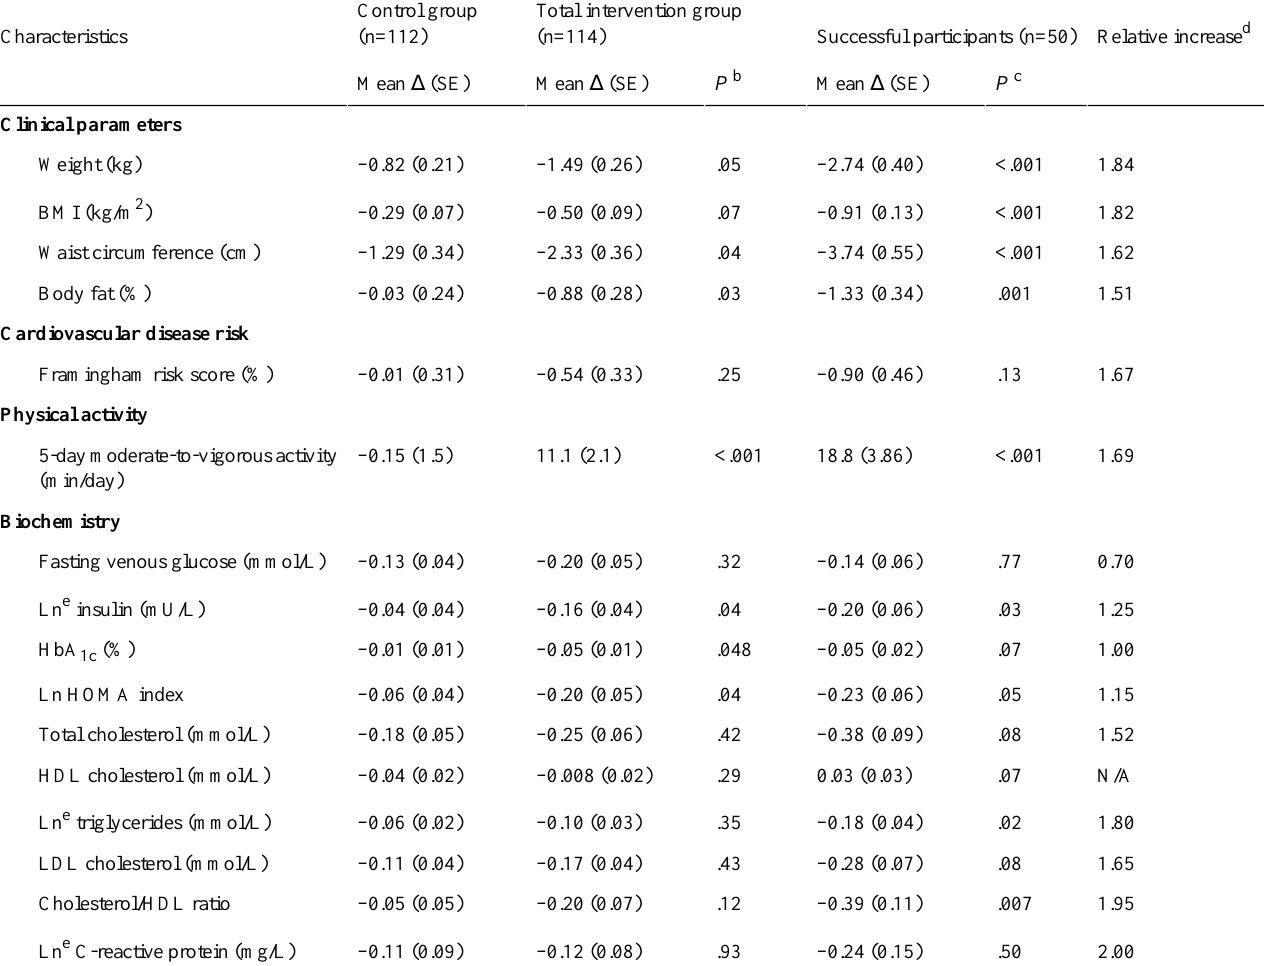
Table 2. Results for clinical parameters and glucose metabolism of successful participants compared to the total control group.